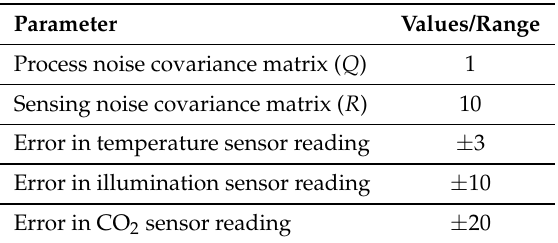
Table 3. Parameter settings for the analysis of Kalman’s filter